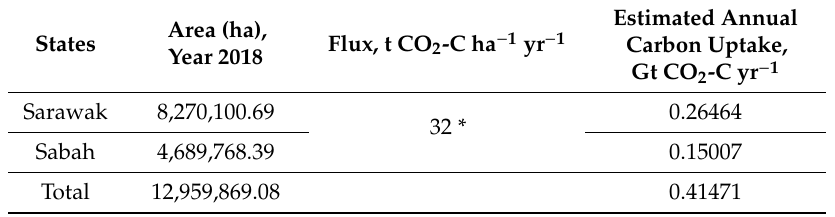
Table 11. Estimated forest annual carbon-CO 2 uptake in Sarawak and Sabah,